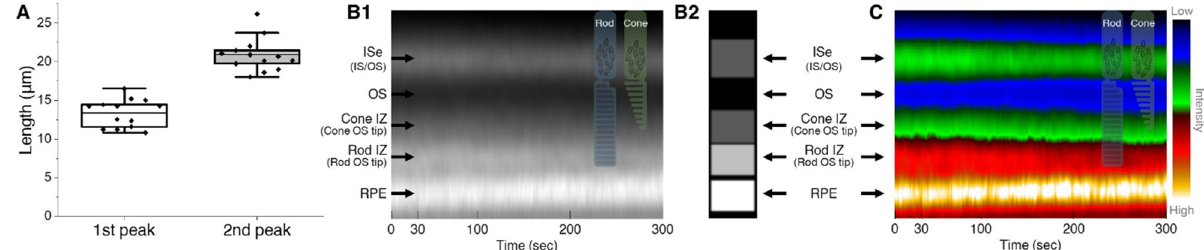
Figure 7. ( A ) Peak-to-peak length measurement from the ISe to double peaks along the photoreceptor OS (N = 13). (B1) An average M-scan image at the outer retinal region. (B2) A simplified intensity distribution model based on (B1). ( C ) OCT intensity in (B1) is depicted with a color-lookup-table “thal” provided in ImageJ software. The intensity range of the lookup table is shown in the bar to the right of the image. ISe inner segment ellipsoid, IS inner segment, OS outer segment, IZ interdigitation zone, RPE retinal pigment epithelium. ( A ) was generated using Origin 2020b (http:// origi nlab. com). (B1–B2) were generated using Microsoft PowerPoint 2019 (http:// micro soft. com). ( C ) was generated using ImageJ 1.52v (https:// imagej. nih. gov/ transition from light to dark is accompanied by an increase in photoreceptor metabolism, resulting in increased oxygen consumption in the retina 45 . The increase in oxygen consumption leads to a proportionate increase in CO 2 and wastewater production into the outer retina, which can acidify the outer retina and ultimately upregulate water removal co-transporters in the RPE. This rapid removal of the acidified water has been linked to significant thinning of the ELM-RPE region 46,47 . In fact, empirically derived acidic conditions by medicine and hypoxia were found to reduce the outer retinal volume directly 48,49 . Consistent with our results, Li et al. 28 observed a sig- nificant reduction of outer retina thickness in the dark-adapted retina. They also reported that light-dependent volume changes in the outer retina varied with the stage of retinal degeneration in retinal degeneration 10 (rd10) mouse model 50 . Berkowitz et al. found strain-specific changes of the outer retina in different light condi- tions. A light-driven expansion of the outer retina was more prominent in C57BL/6 mice than 129S6/SvEvTac mice 29 . Gao et al. 30 further demonstrated that dark adaptation significantly reduced the magnitude and width of a hypo-reflective band between the photoreceptor OS and RPE. In addition, Guziewicz et al. showed that the hypo-reflective band became more profound during the transition from dark to light in the canine BEST1 disease model, manifesting retinal abnormalities at the photoreceptor-RPE interface associated with defects in the RPE microvilli ensheathment 51 . Taken together, dynamic ORG measurement of dark adaptation can serve as a functional indicator for RPE-mediated water transport in the outer retina. However, the water transport could not explain the altered integrity of the 3rd outer retinal bands (i.e., IZ and OS tips). We instead hypothesize that interdigitating properties between the OS tip and RPE apical pro- cesses may be changed. In this study, we found double peaks along with the OS (Figs. 6A and 7), and these peaks became enervated during the dark adaptation period. This morphological configuration is quite similar to an axial positioning of cone and rod OS tips in the perifoveal outer retina in humans 52–55 . However, the putative cone IZ band has low reflectivity compared to the rod IZ band in the mouse retina, which is probably due to a sparse cone population. Considering the cone OS is shorter in length (Fig. 7A) and lower in occupancy than the rod OS in the mouse retina, the first and second peak most likely correspond to the cone and rod OS tip region, respectively. This ensheathing configuration has been also named as the contact cylinder 53 , where the RPE’s long apical microvilli interdigitate with the photoreceptor OSs, supporting an adhesion between the retina and RPE. Microvilli are capable of active contraction while interdigitating with the OS 51 . It was demonstrated that the force required to detach the retina from the RPE was 20% greater in the light-adapted retina than in the dark-adapted retina 56 . Also, retinal adhesion in wild-type mice increased by 58% after light adaptation 57 . To support the firm retinal attachment, tight ensheathment might be necessary for light adaptation, presumably manifesting high reflectance in the 3rd band. Conversely, the alleviated tension in darkness along with outer retinal thinning may loosen this interconnection, presumably manifesting low reflectance in the 3rd band. It should be noted that ensheathment of the OS by microvilli is not the only mechanism of retinal adhesion; interphotoreceptor matrix proteins simultaneously contribute to lowering retinal adhesive force in darkness 5,58 . In addition, either light